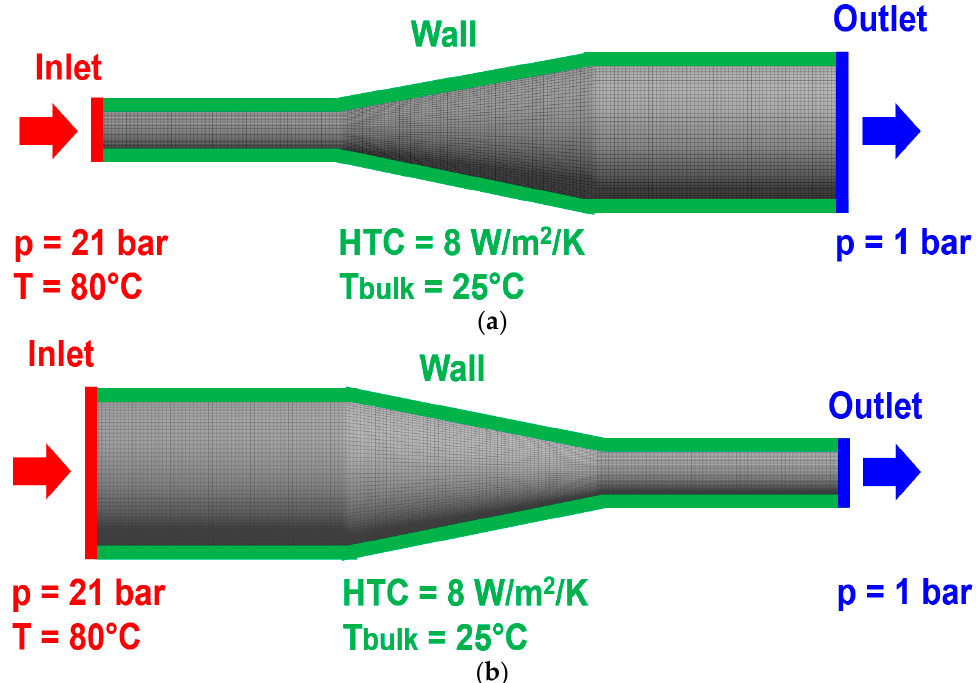
Figure 10. Boundary conditions in ( a ) diffuser simulation case and ( b ) confusor simulation case.